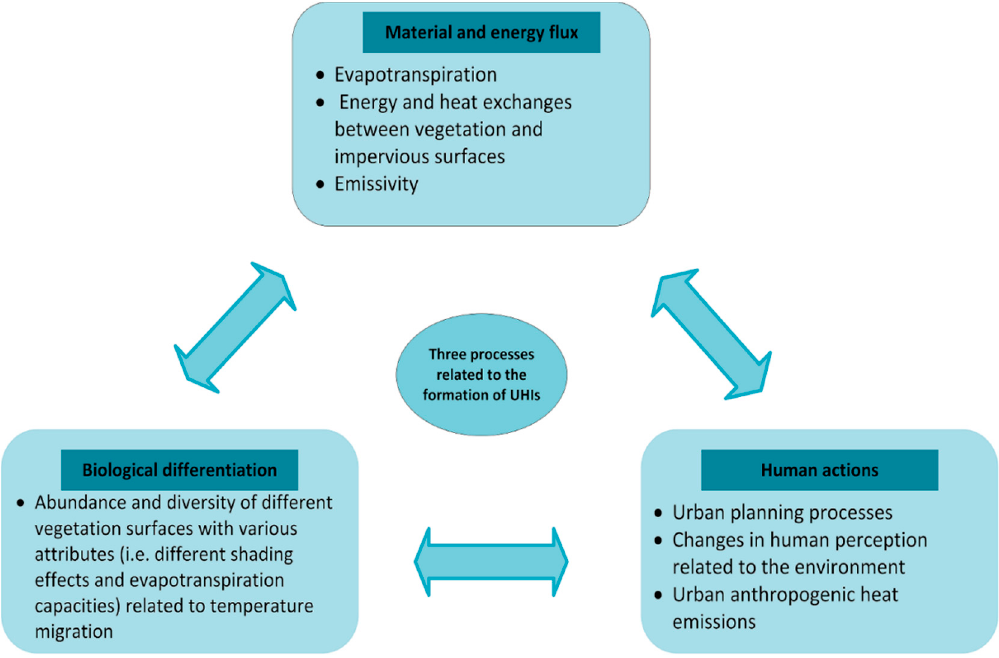
Figure 2. The reciprocal interaction between the processes of ‘energy and material flows’, ‘biotic differentiation’, and ‘human action’ (adapted from Pickett et al. [46]) contribute to the formation of UHI. For each process realm, several variables have been outlined.